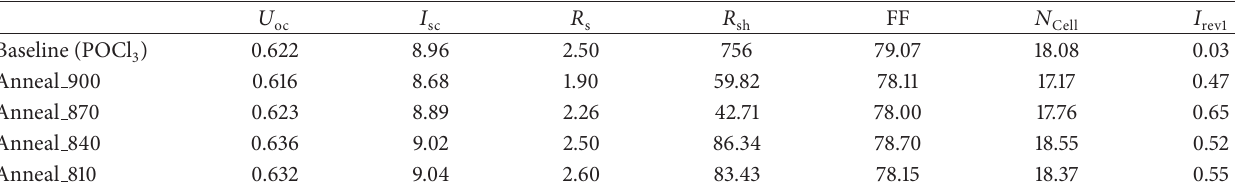
Table 6: Characteristics of POCl